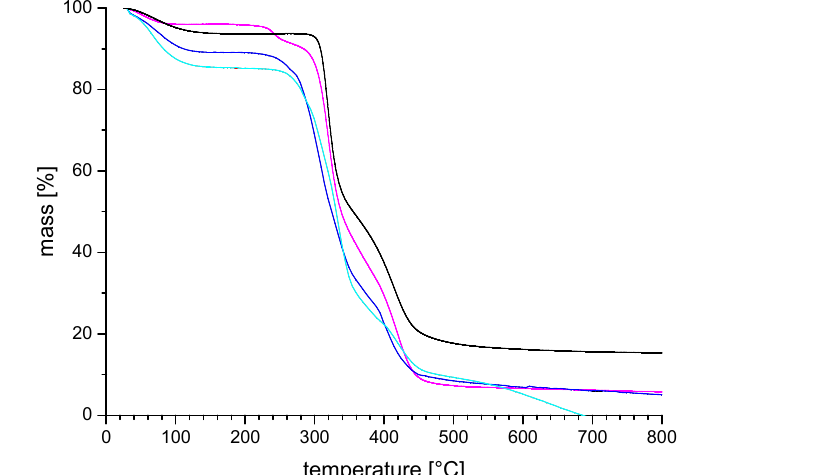
Figure 2. Exemplary TGA thermograms of zwitterionic polymer series P-4: ( −−− ) = P-4a; ( −−− ) = P-4b; ( −−− ) = P-4c; ( −−− ) = P-4d.